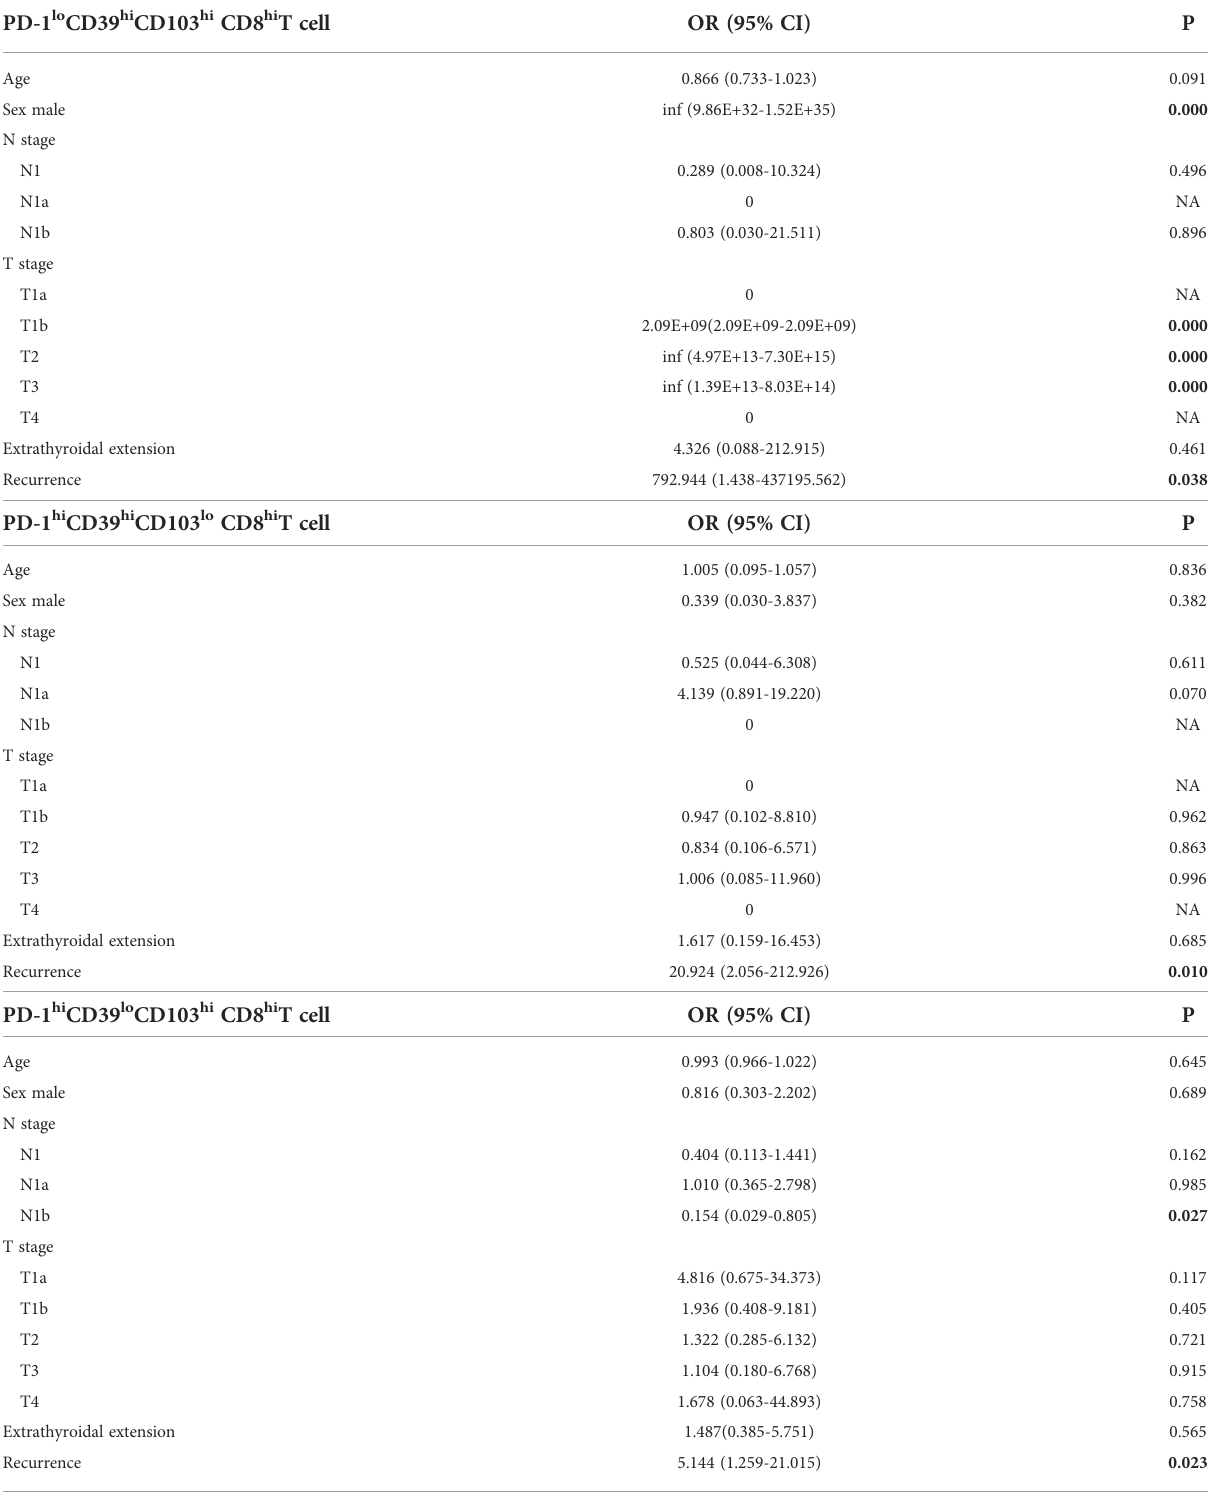
TABLE 2 Multinomial logistic regression analysis of clinical parameters associated with PD-1 lo CD39 hi CD103 hi CD8 hi T, PD-1 hi CD39 hi CD103